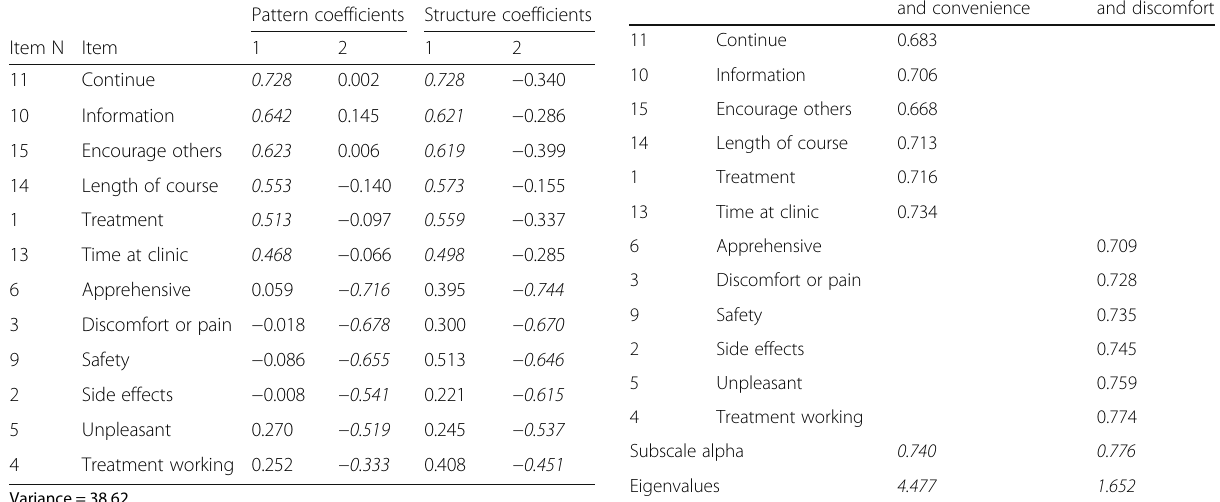
Table 4 Internal consistency reliability for each of the Table 3 Pattern and structure matrix for principal axis factoring with oblimin rotation of two-factor Solution of MacTSQ items Pattern coefficients Structure coefficients